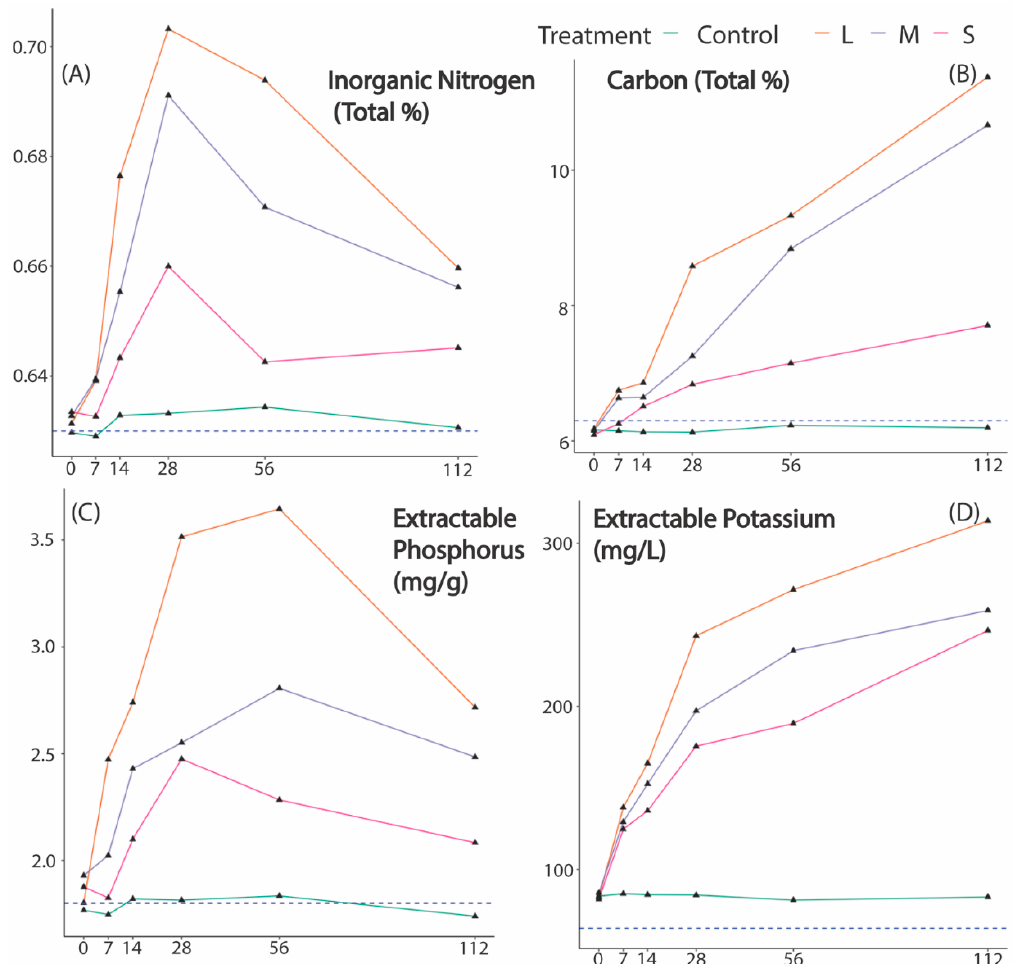
Figure 2. Changes in the soil nutrient contents: ( A ) total nitrogen, ( B ) total carbon, ( C ) extractable phosphorus, and ( D ) extractable potassium over 112 days. The horizontal dashed lines are published evidence of the baseline bioavailable nutrients found in Nicholson (1976) [27], a previous study in the same area and soil type as the current study. Table 3. Contrast tests for levels of treatment relative to baseline (* denotes significance). Nutrient Treatment